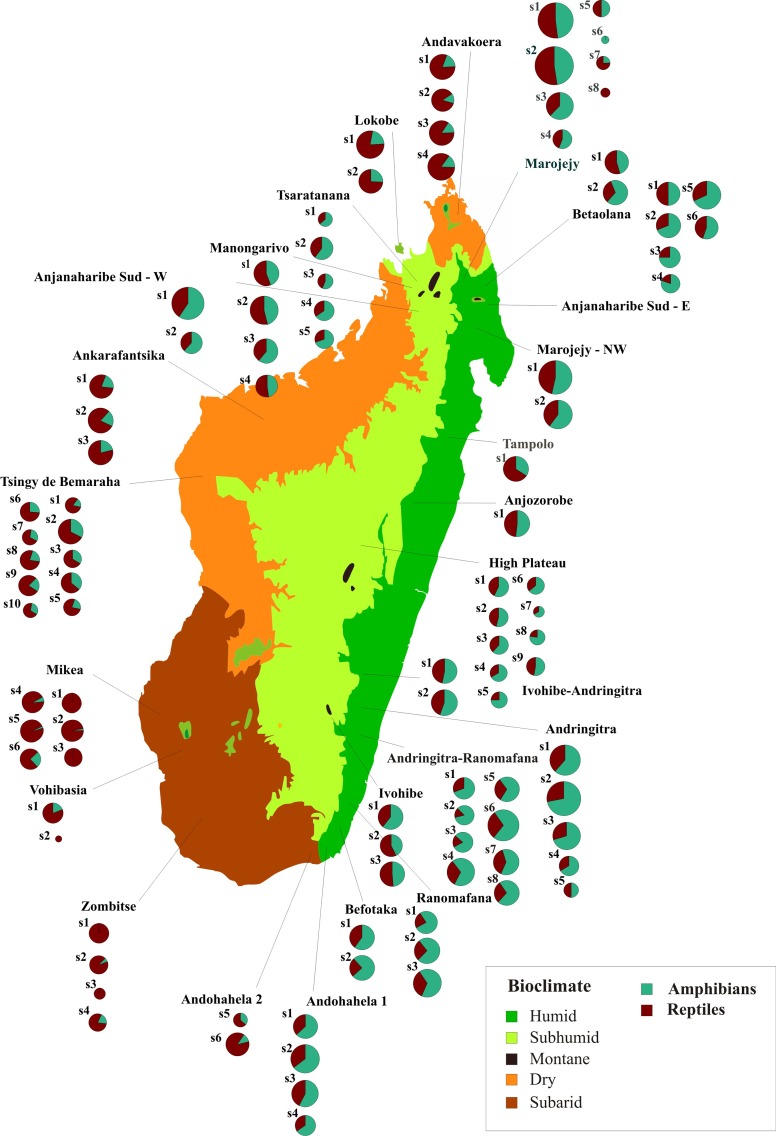
Species numbers and proportion of amphibians and reptiles recorded during herpetological inventories in Madagascar.Each pie chart represents one surveyed site (i.e., the area around one campsite at a specific elevation) and thus a community of co-occurring amphibian and reptile species. Pie area is proportional to the number of species; proportion of amphibians vs. reptiles in the community is indicated by colors. See S1 Table for a list of sites and references.